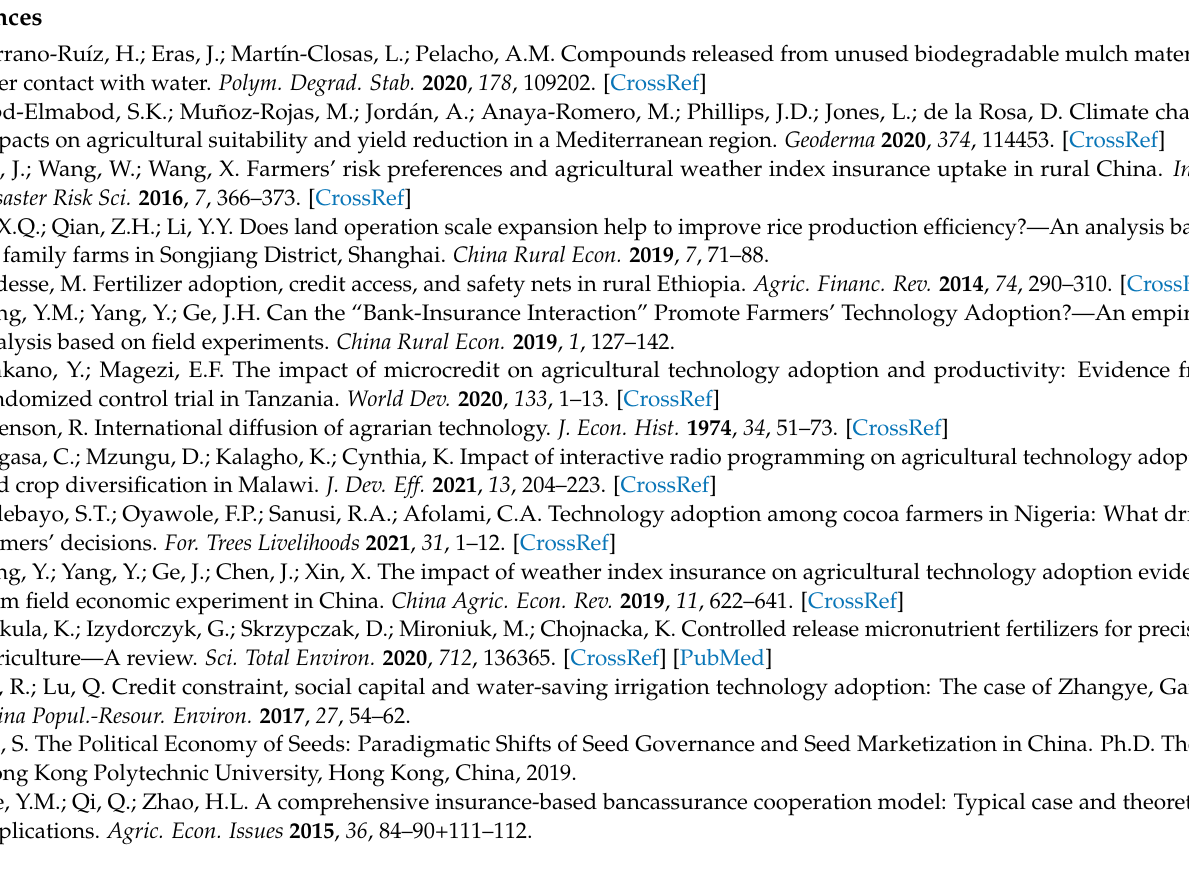
Figure A1. Data research and farmer interaction. Source: Photographed and compiled by the authors in July–August